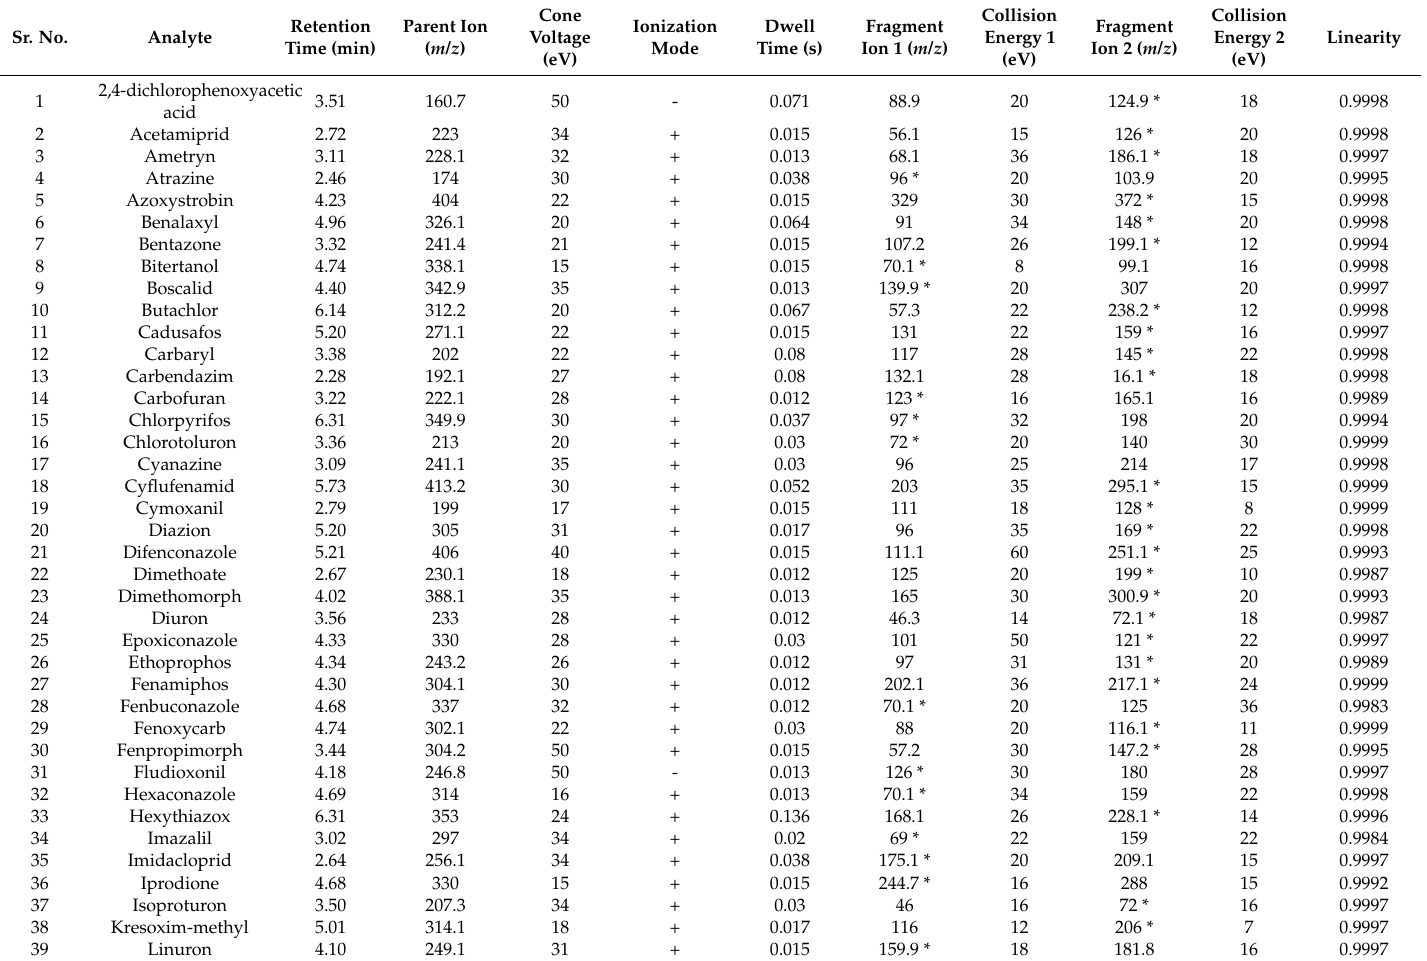
Table 1. Parameters of acquisition method and linearity results of LC-MS/MS analysis of 81